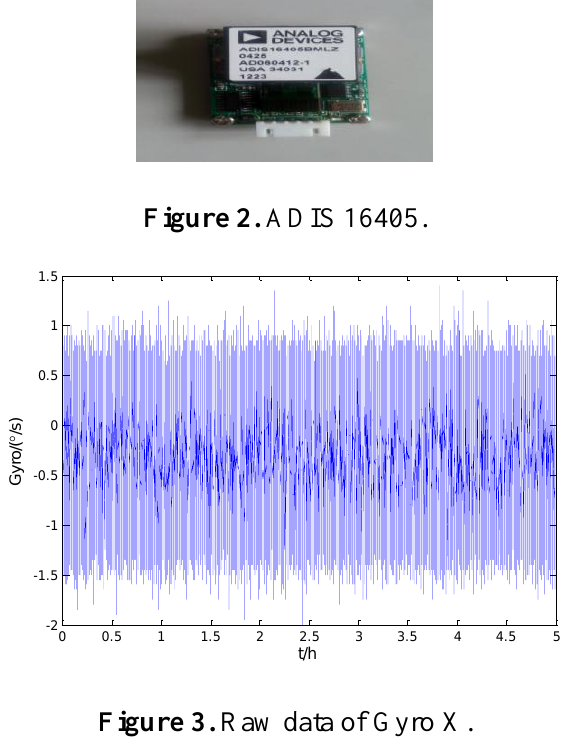
Figure 3. Raw data of Gyro